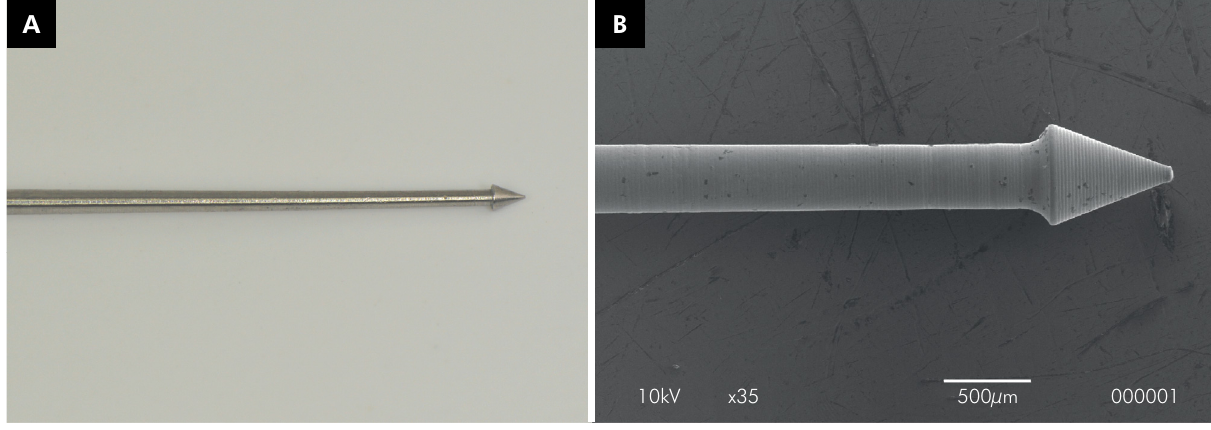
Figure 1. (A) Ultrasonic Clearsonic tip and (B) micro-computed tomography image of the Clearsonic tip (original magnification, 35x).